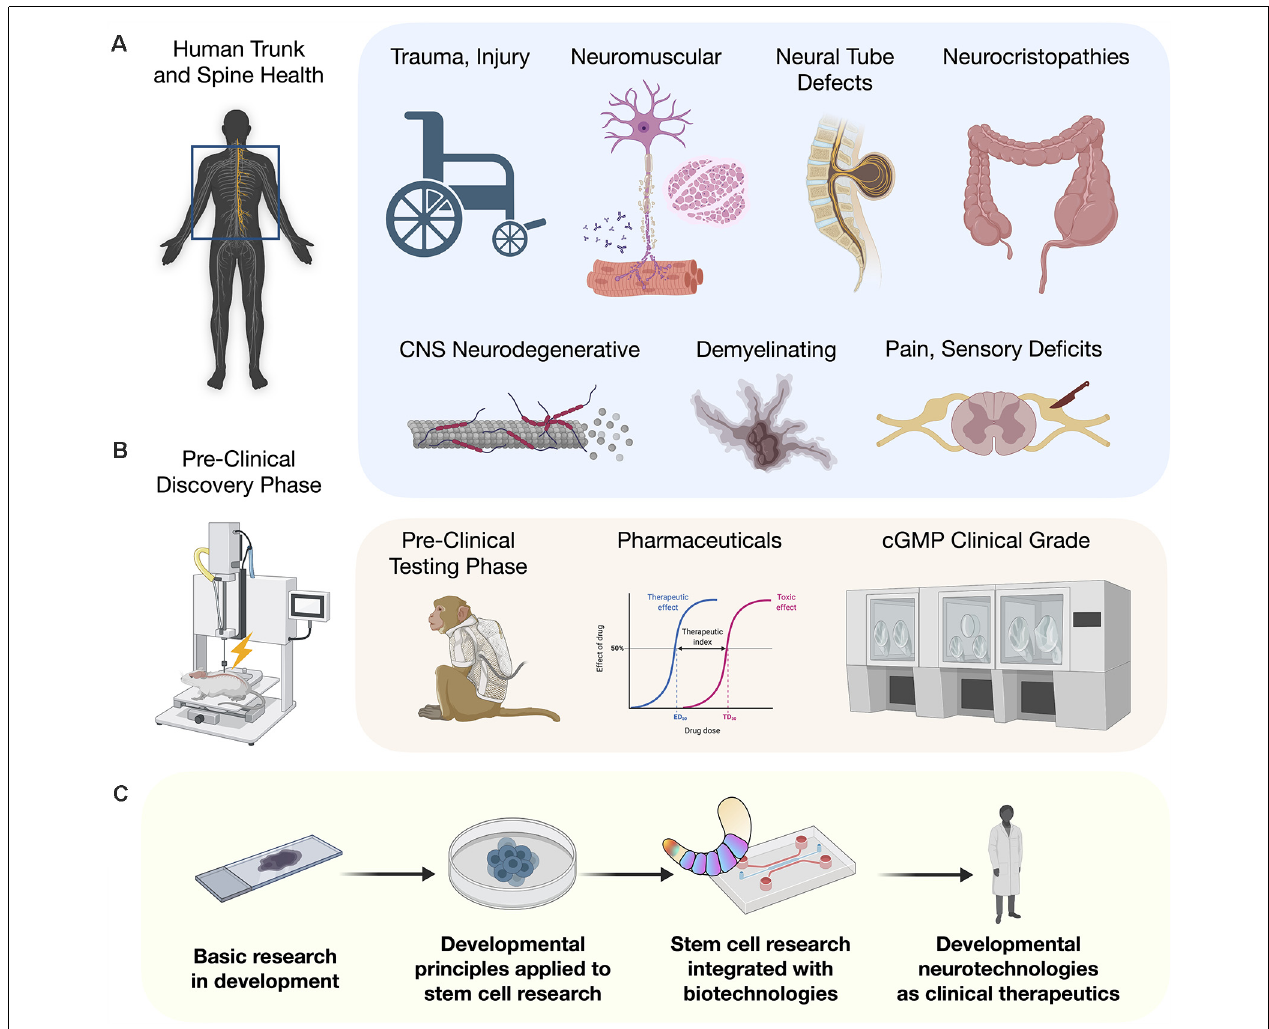
FIGURE 5 | Clinical potential of stem cells and developmental neurotechnologies. (A) Conditions of the human trunk and spine that will benefit from developmental neurotechnologies. Examples include trauma and spinal cord injury (SCI), neuromuscular disorders such as amyotrophic lateral sclerosis (ALS) and myasthenia gravis, neural tube closure defects such as spina bifida that relate to PAX3, neurocristopathies such as Hirschsprung’s disease that result from NCC migration defects, CNS neurodegeneration, demyelinating disorders such as multiple sclerosis, and sensory disorders such as neuropathic pain. (B) Clinical stages of developmental neurotechnology discovery and testing from pre-clinical through to current good manufacturing processes (cGMP). (C) The developmental neurotechnology paradigm to generate clinical therapies and disease models by merging stem cell developmental principles with